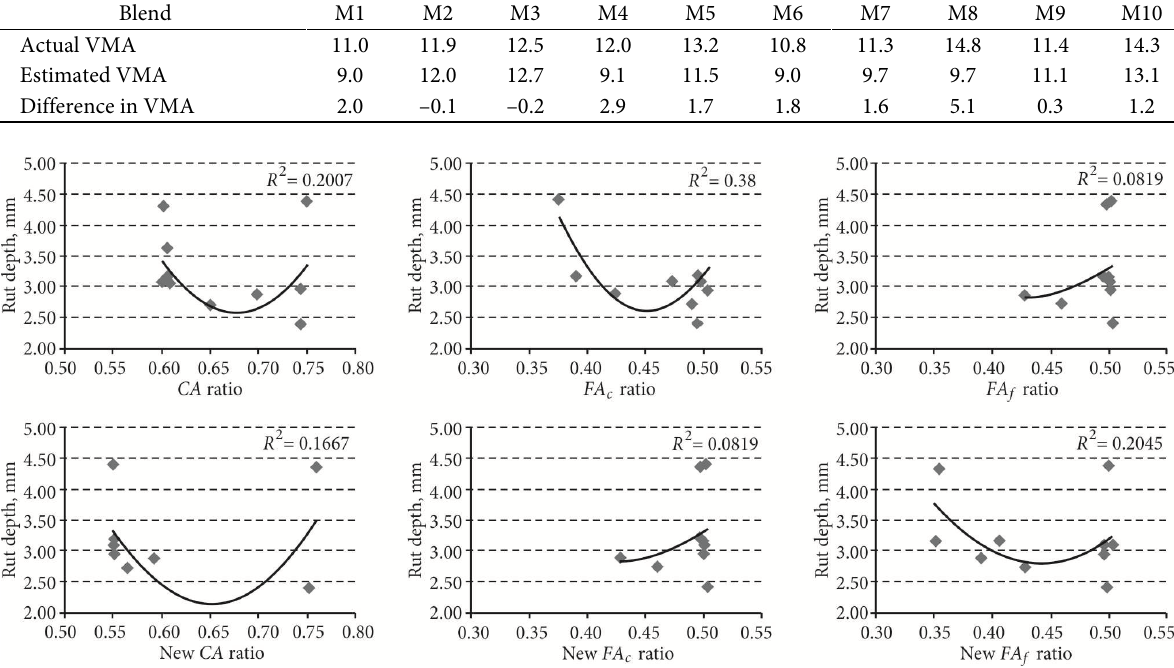
Table 7. The difference between an estimated VMA and the actual VMA